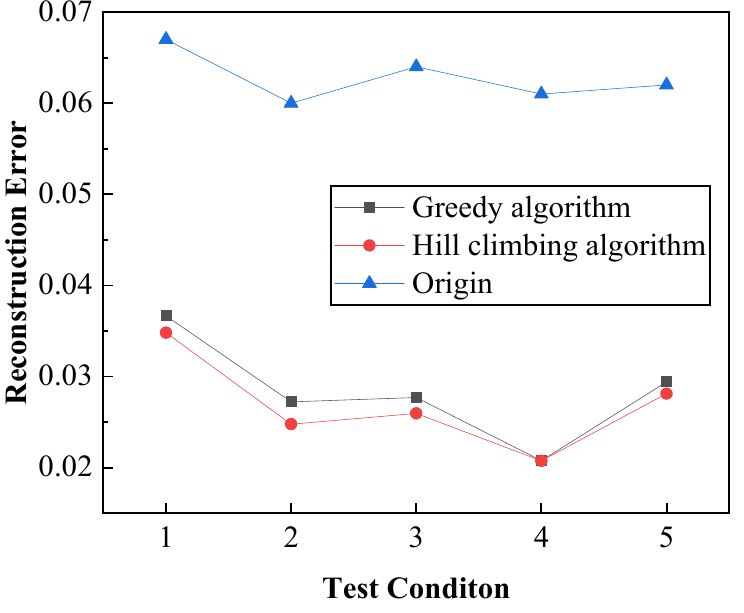
Figure 9. Comparison of Optimized Effects.